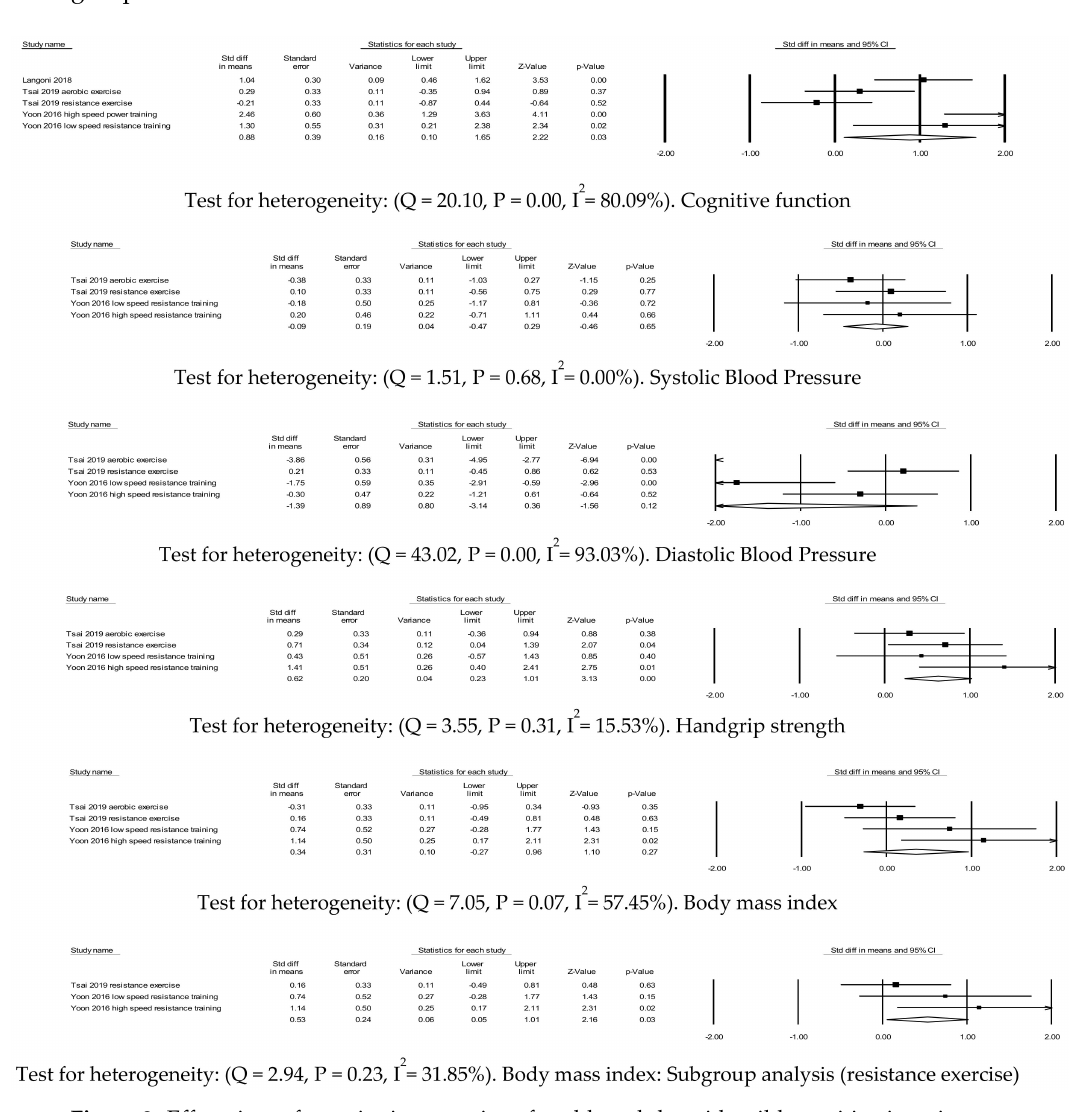
Figure 2. E ff ect sizes of exercise interventions for older adults with mild cognitive